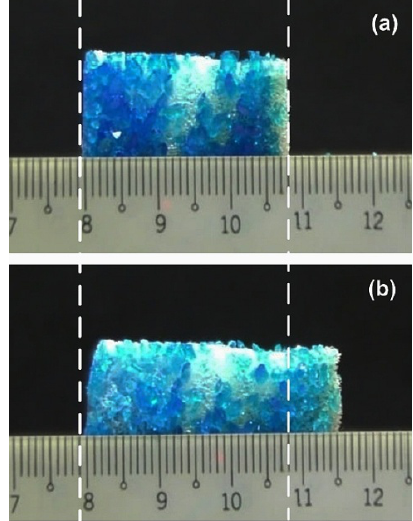
Figure 13. Impact-induced shape recovery in an elastic sponge–CuSO ( a ) After programming; and ( b ) after being hammered in the vertical direction